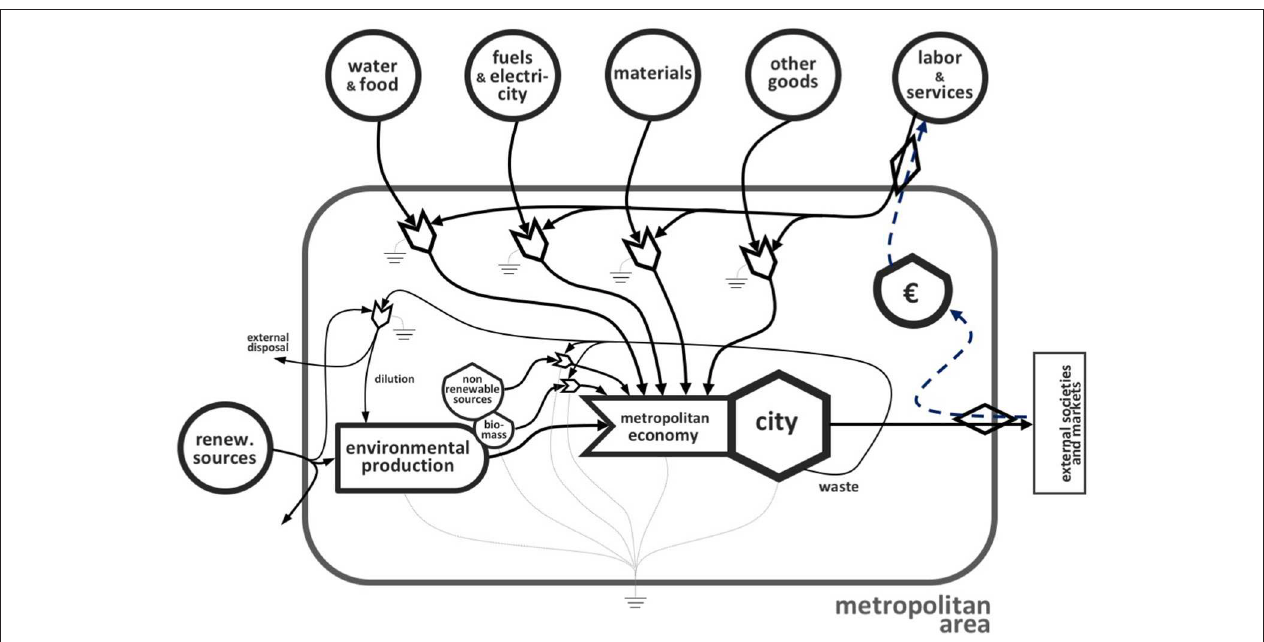
FIGURE 1 | Systems diagram of a metropolitan